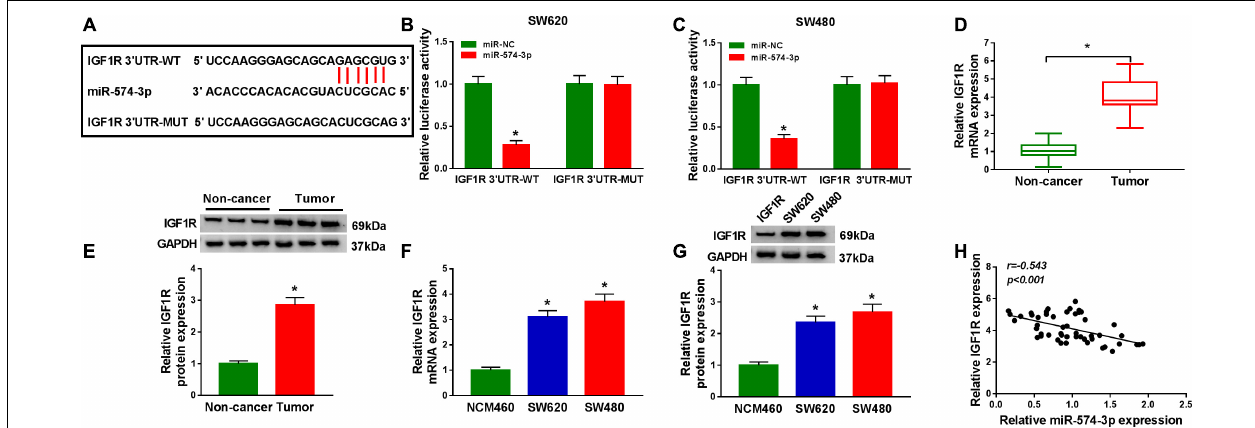
FIGURE 6 | MiR-574-3p could target IGF1R. (A) The sequences of IGF1R 3 (cid:48) UTR-WT and IGF1R 3 (cid:48) UTR-MUT were shown. (B,C) The interaction between IGF1R 3 (cid:48) UTR and miR-574-3p was confirmed using dual-luciferase reporter assay. (D,E) The mRNA and protein levels of IGF1R in CRC tumor tissues and non-cancer tissues were measured using qRT-PCR and WB analysis. (F,G) QRT-PCR and WB analysis were used to detect the mRNA and protein levels of IGF1R in CRC cell lines (SW620 and SW480) and NCM460 cells. (H) The correlation between IGF1R and miR-574-3p was analyzed using Pearson correlation analysis. * P < 0.05.